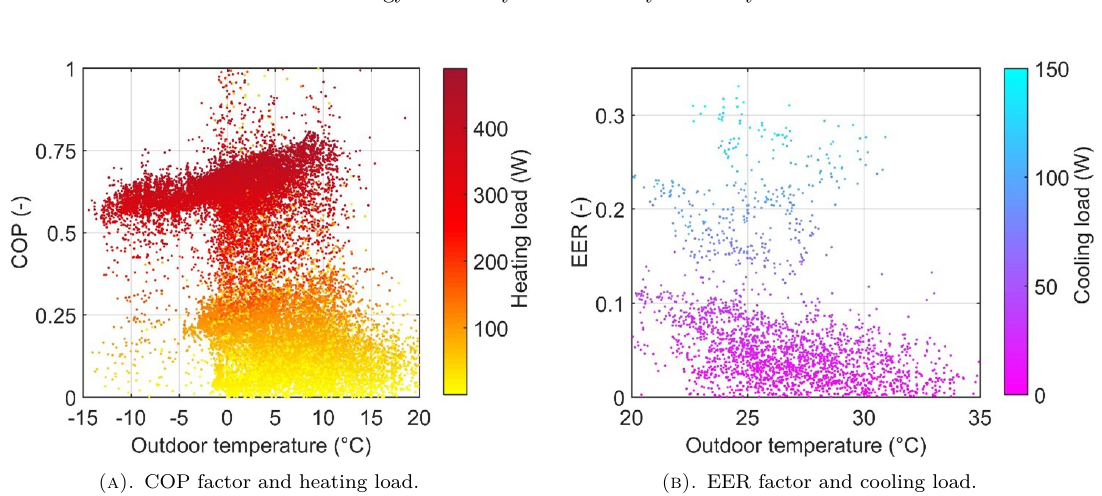
Table 3. Energy autonomy and efficiency: monthly overview.